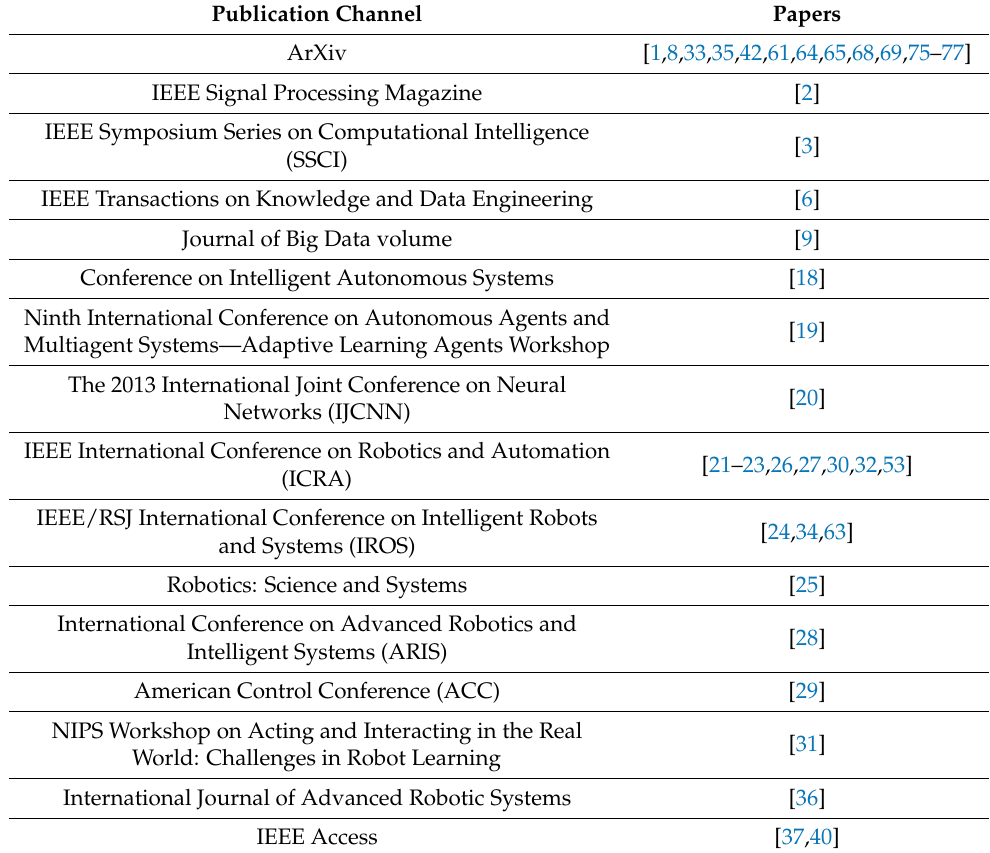
Figure 5. Distribution of papers based on publication type. Table 4. Distribution of papers based on publication channels.